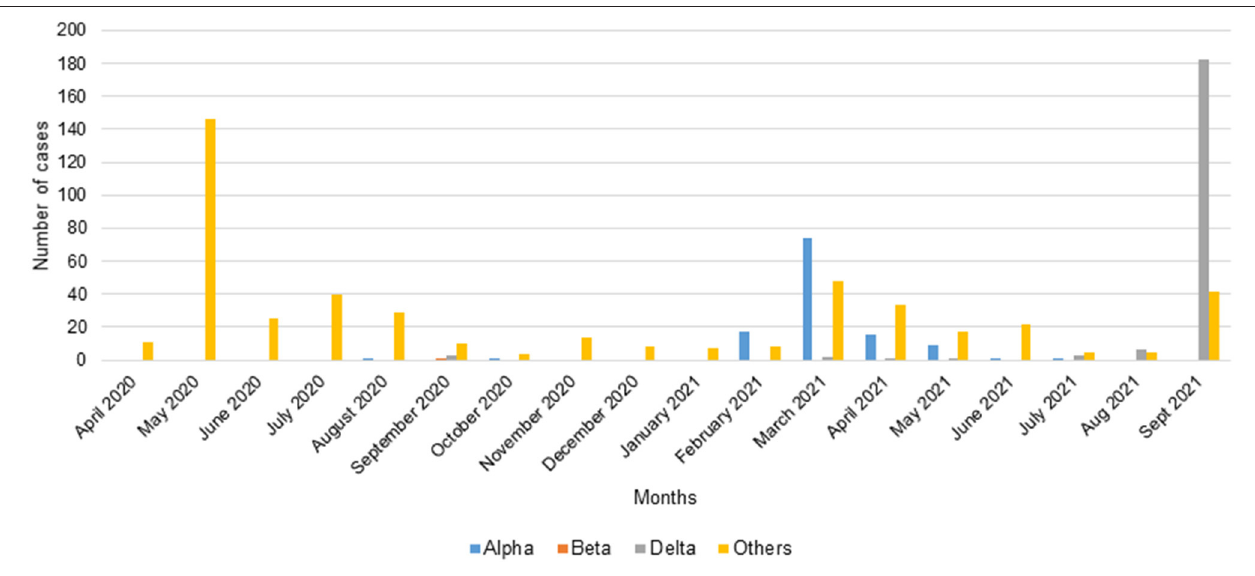
FIGURE 3 | Number of cases of VOCs Alpha, Beta, Delta screened by qPCR.